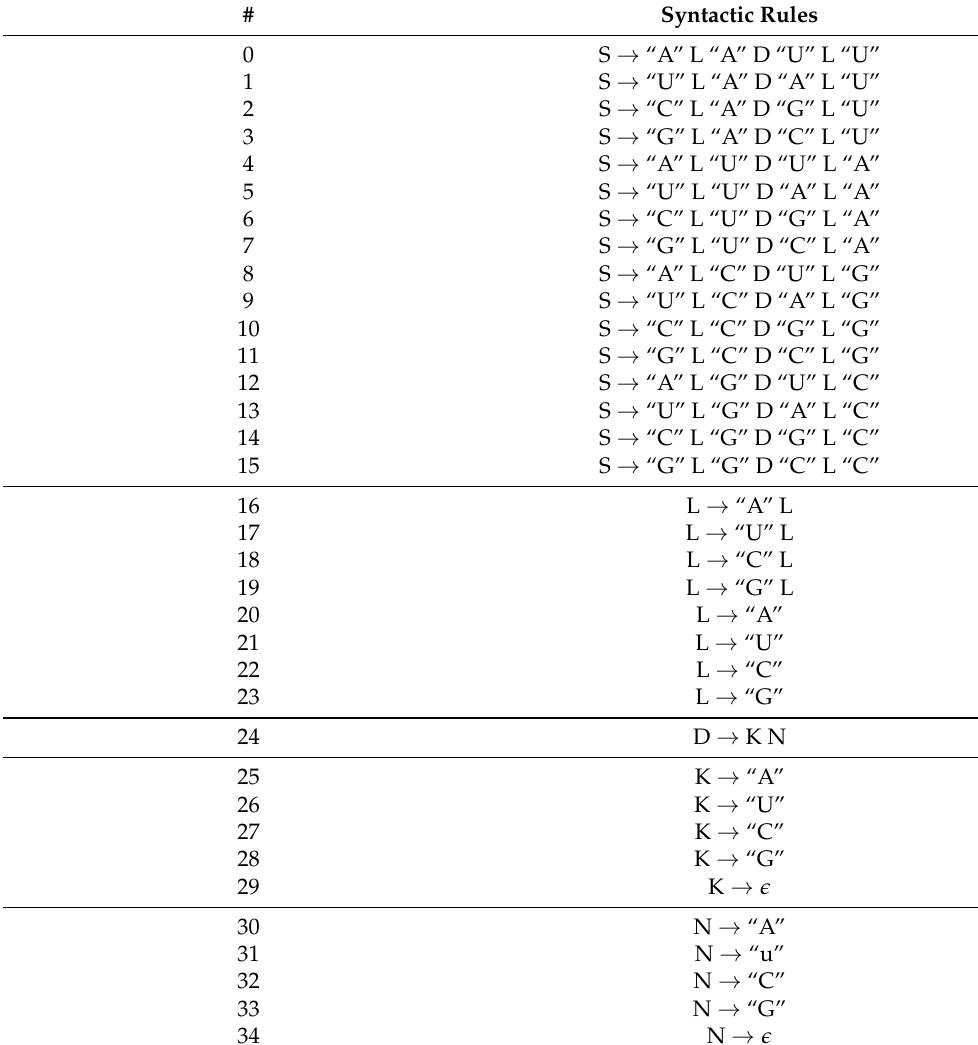
Table 1. Description of AG RNA